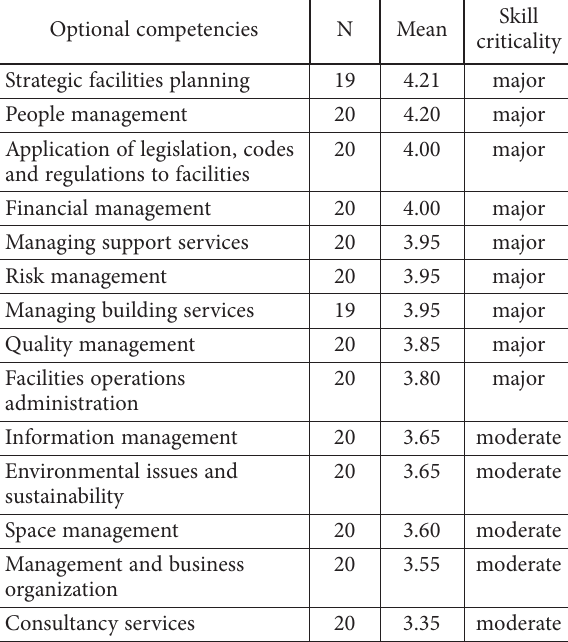
Table 6. rankings of optional competencies